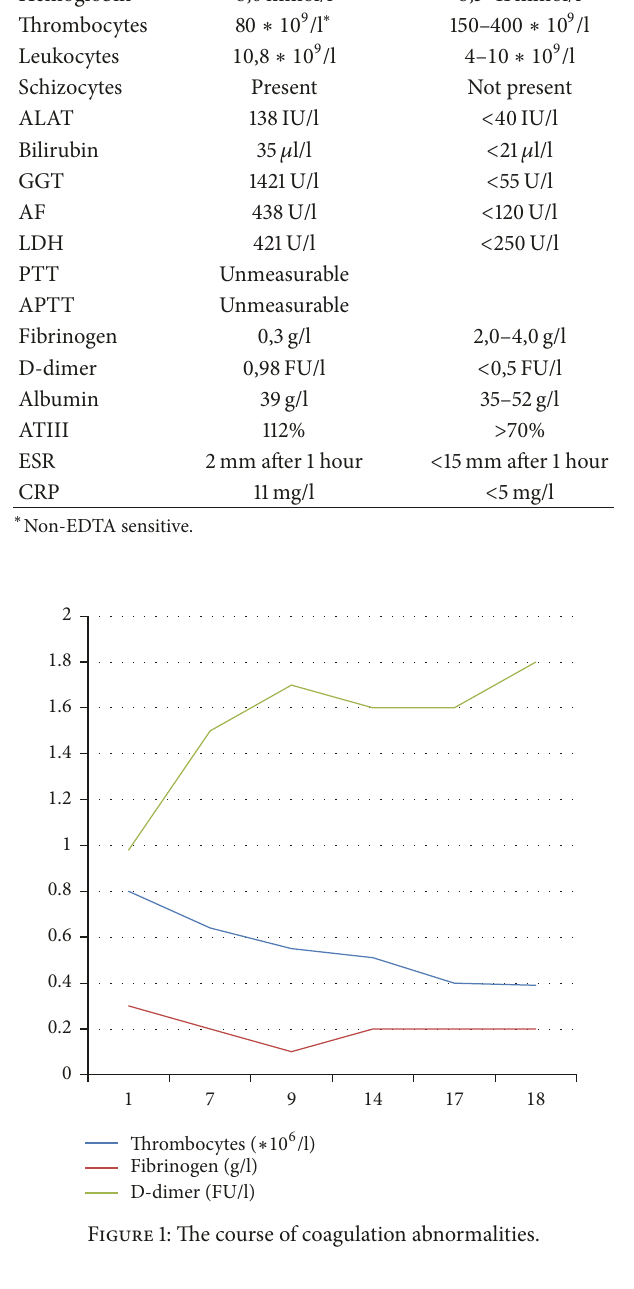
derivate because of his atrial fibrillation. His INR was within the therapeutic range one week before admission, while using normal dosages of acenocoumarol. He had stopped the anticoagulation in preparation for a liver biopsy. The course of the coagulation abnormalities is shown in Figure 1